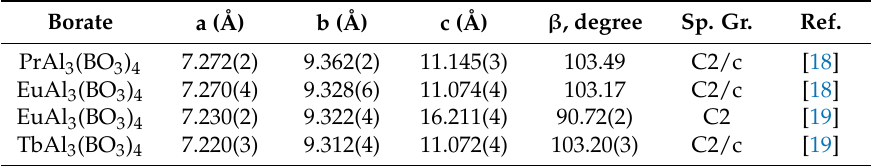
Table 2. Unit cell parameters of monoclinic RAl 3 (BO 3 ) 4